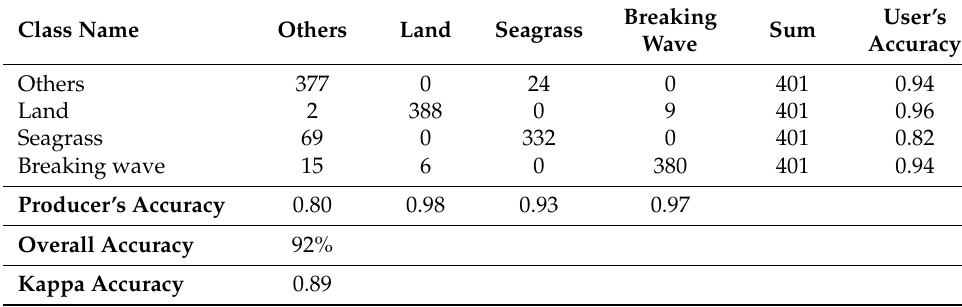
Table 4. Confusion matrix for seagrass classification using Geoeye-1.